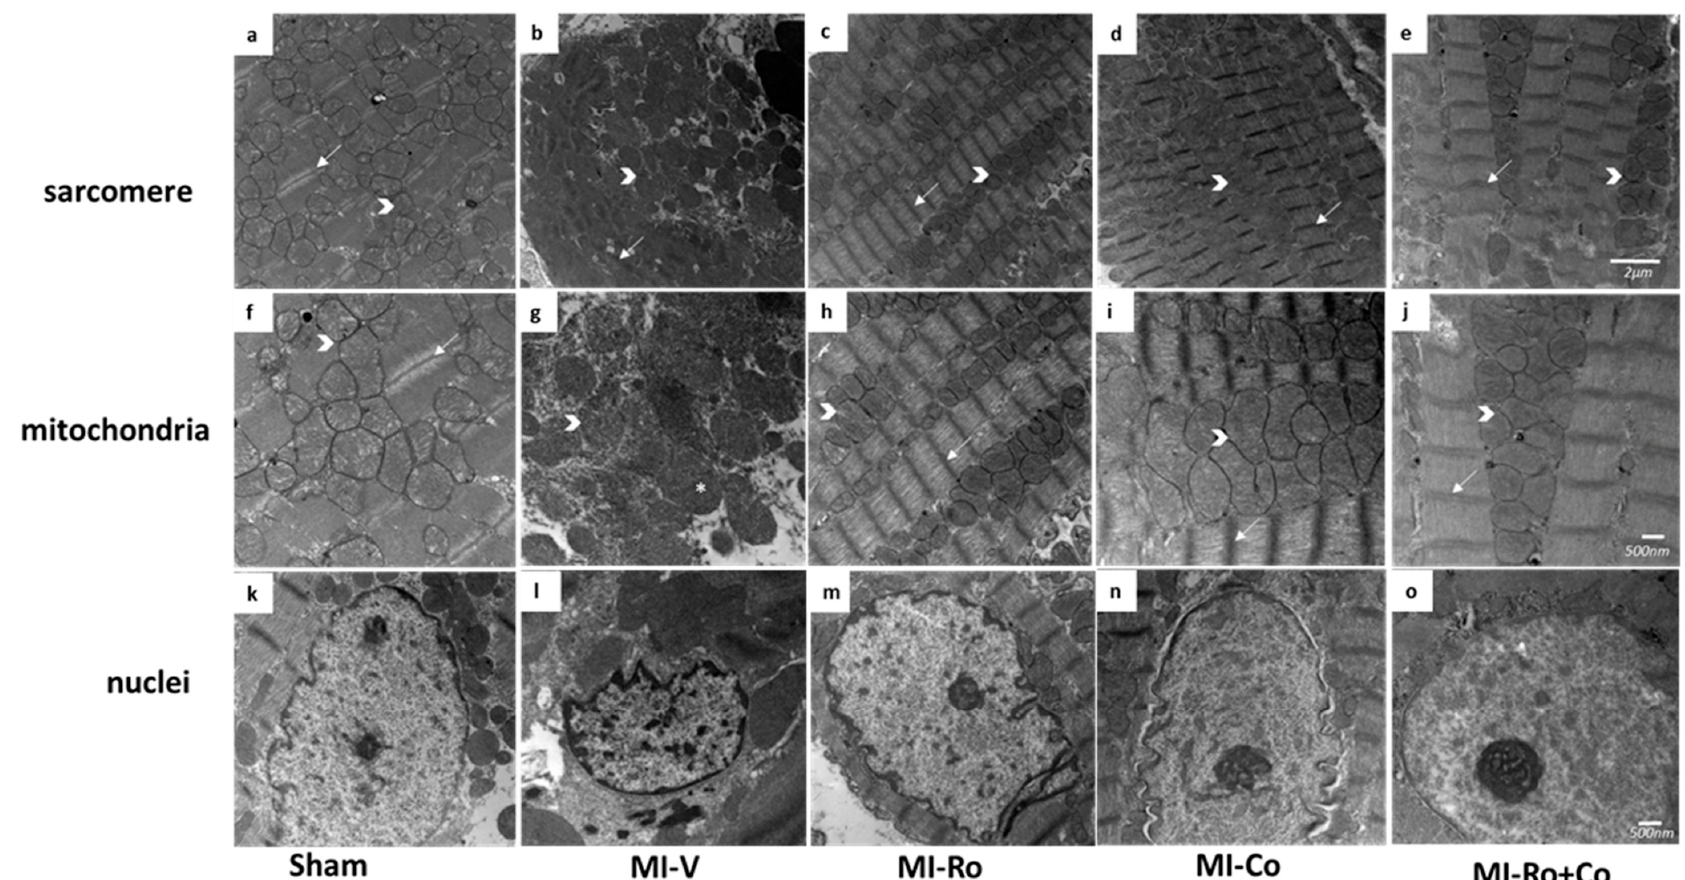
Figure 8. Extracts prevent ultrastructural damage in myocardium of infarcted rats. Sham ( a , f , k ); myocardial infarction (MI)-vehicle treated (MI-V, ( b , g , l )); MI- Ro ( c , h , m ); MI- Co ( d , i , n ); and MI- Ro+Co ( e , j , o ) were analyzed by electron microscopy. The figure depicts the sarcomere showing mitochondria arranged in rows ( ); band I ( → ) and * showed swealling mitochondria. Magnification 12,000× for sarcomere ( a – e ), and the scale bar represents 500 nm; 20,000× for mitochondria and nuclei, and the scale bar represents 2 µm ( f – o ).